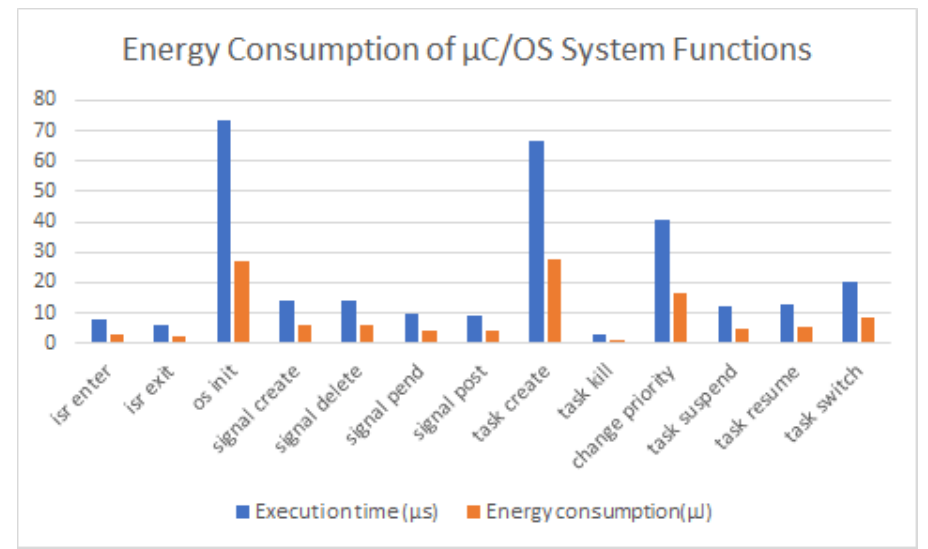
Figure 9. Energy consumption of the μ C/OS system functions measured with the standalone design.